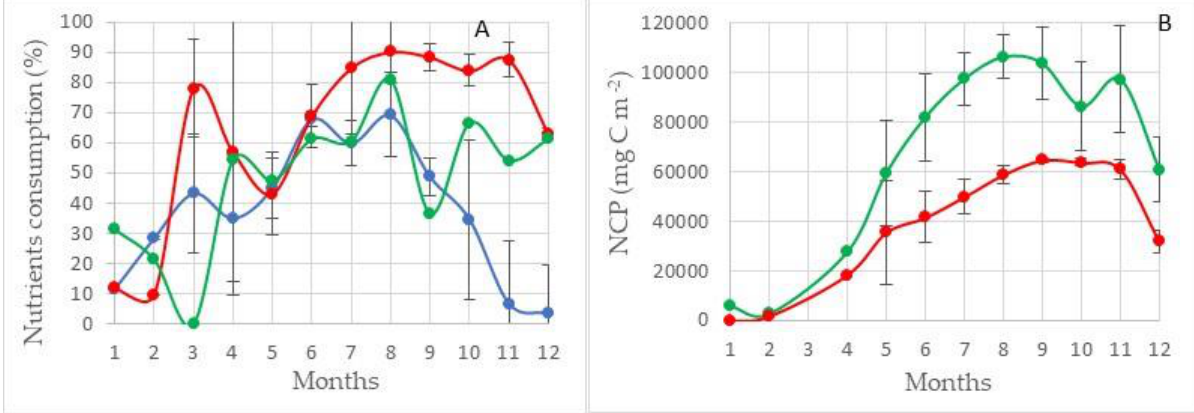
Figure 10. Annual cycle of primary production and nutrient consumption ( A ) and primary produc- tion ( B ) in Region III; ( A ) is the consumed part of the nutrient supply in the process of photosynthesis (blue: mineral phosphorus, red: mineral nitrogen, green: silicon); ( B ) primary production (green: NCP Si ; red: NCP N ).